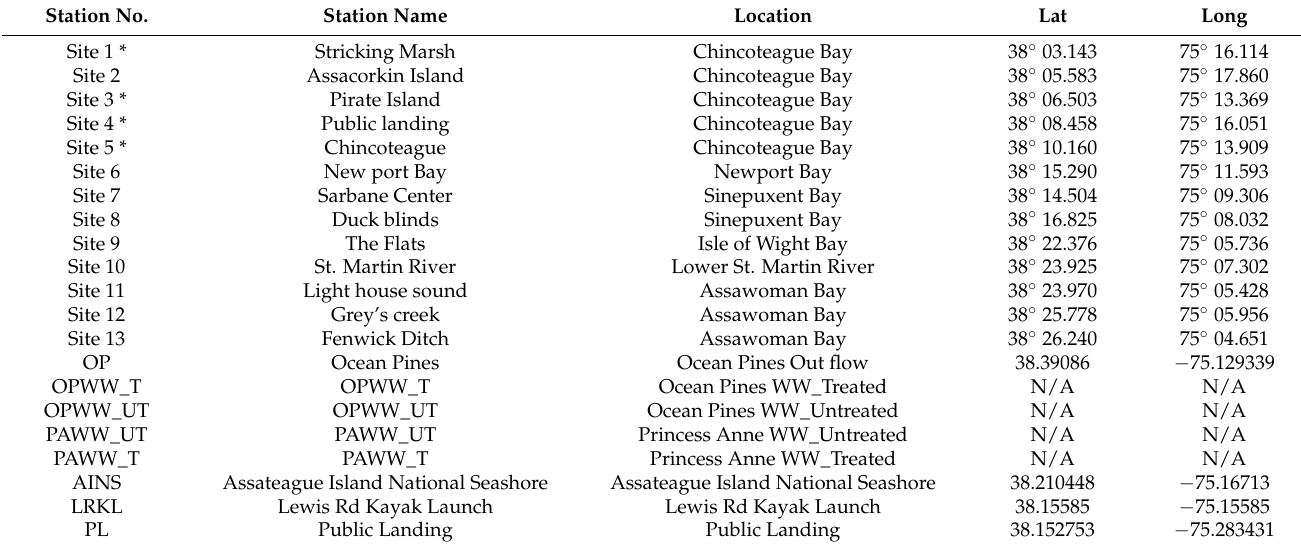
Table 2. Description of the sampling